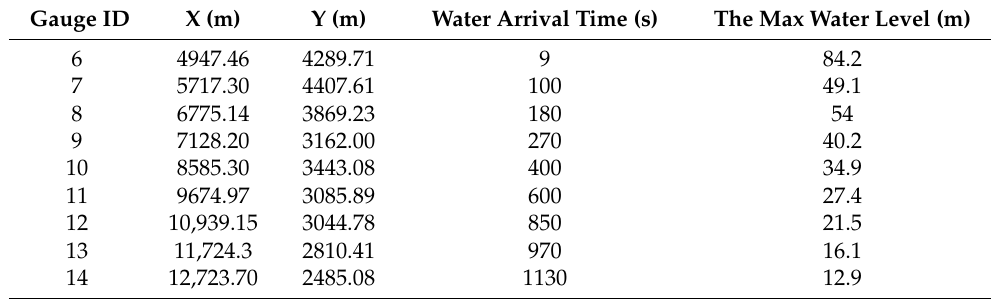
Table 1. Information sheet of